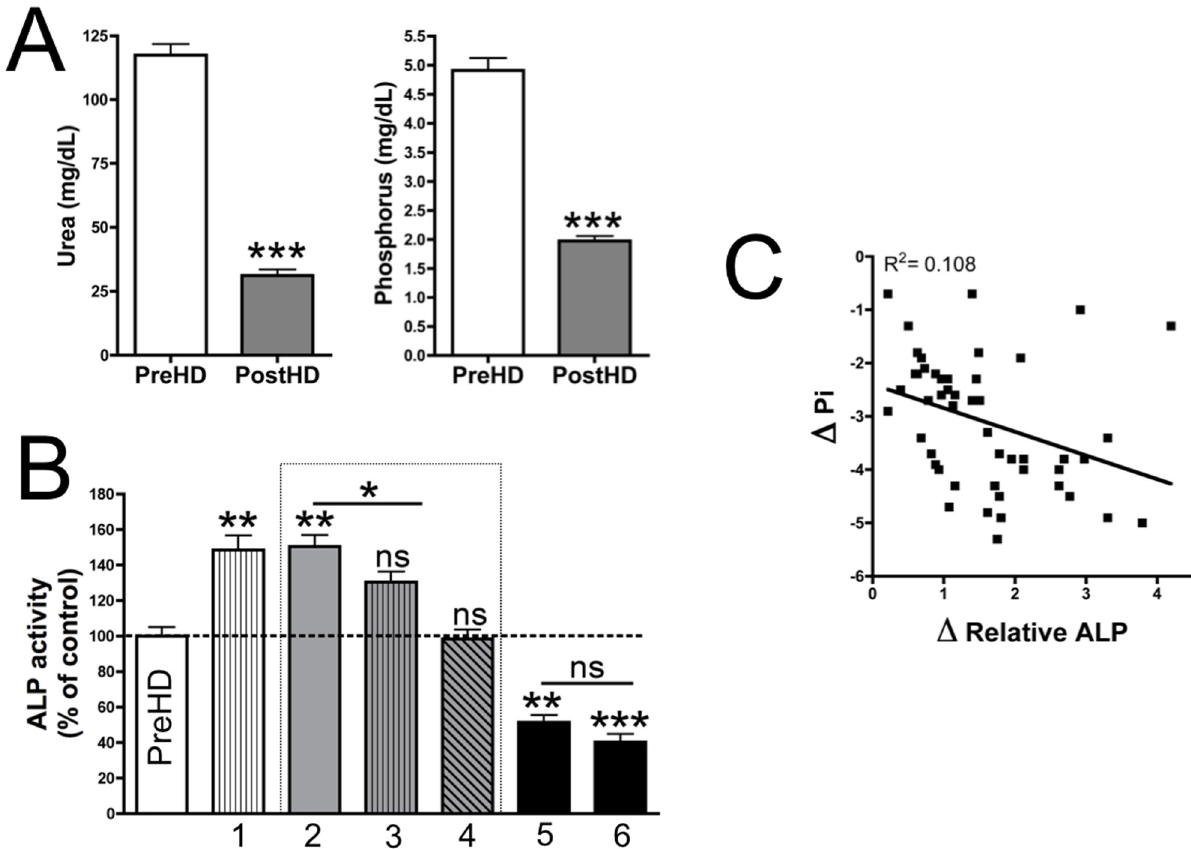
Fig 4. Plasma phosphate levels inhibit ALP activity. ( A ) PreHD (left) and postHD (right) levels of urea and phosphate in plasma. Results are represented as mean ± SEM (n = 45). Wilcoxon ’ s matched pairs test was used for statistical analysis. ( B ) ALP activities of post-hemodialysis samples (with the exception of the controls, which were pre-hemodialysis samples) without or with potential inhibitors: ( 1 ) 120 mg/mL (20 mmol/L) urea; ( 2 ) no addition; ( 3 ) 4.5 mg/dL (1.5 mmol/L) inorganic phosphate; ( 4 ) 9 mg/dL inorganic phosphate; ( 5 ) 20 mmol/L EDTA; and ( 6 ) 100 μ mol/L levamisole. Results are represented as mean ± SEM (n = 45). For statistical analysis, Friedman ’ s one- way ANOVA test and Dunn ’ s post-test were used. ( C ) The scattergraph demonstrates a correlation between Δ Pi (the difference in post- and pre-hemodialysis phosphate levels) and Δ ALP (the difference in post- and pre-hemodialysis ALP levels). PreHD, pre-hemodialysis; PostHD, post-hemodialysis. * P < 0.05; ** P < 0.01; *** P < 0.001